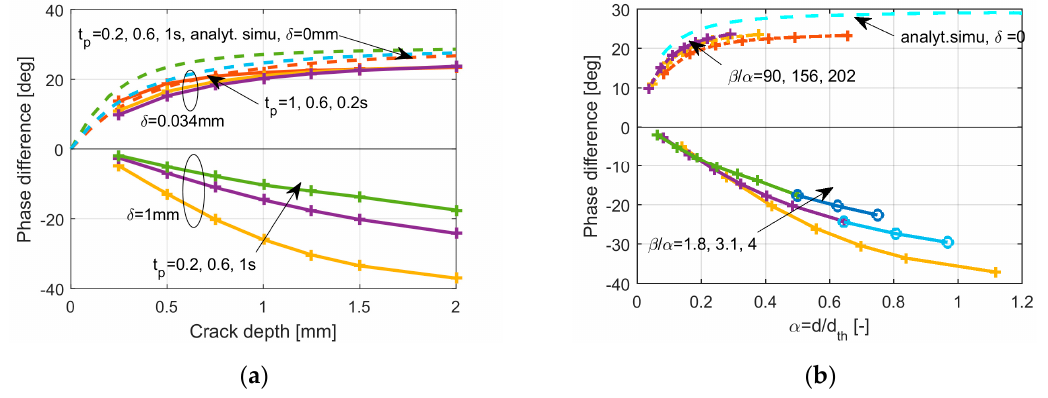
Figure 25. ( a ) Phase difference depending on the crack depths, calculated for two penetration depths and for three heating pulse durations; ( b ) normalized curves for ferro-magnetic (dash-dot lines) and for non-magnetic (solid lines) steel. Values marked with “+” are calculated for d = 1 mm and with “o” for d = 0.5 mm; both figures also show the same analytically calculated curves plotted as per Figure 6b,d.